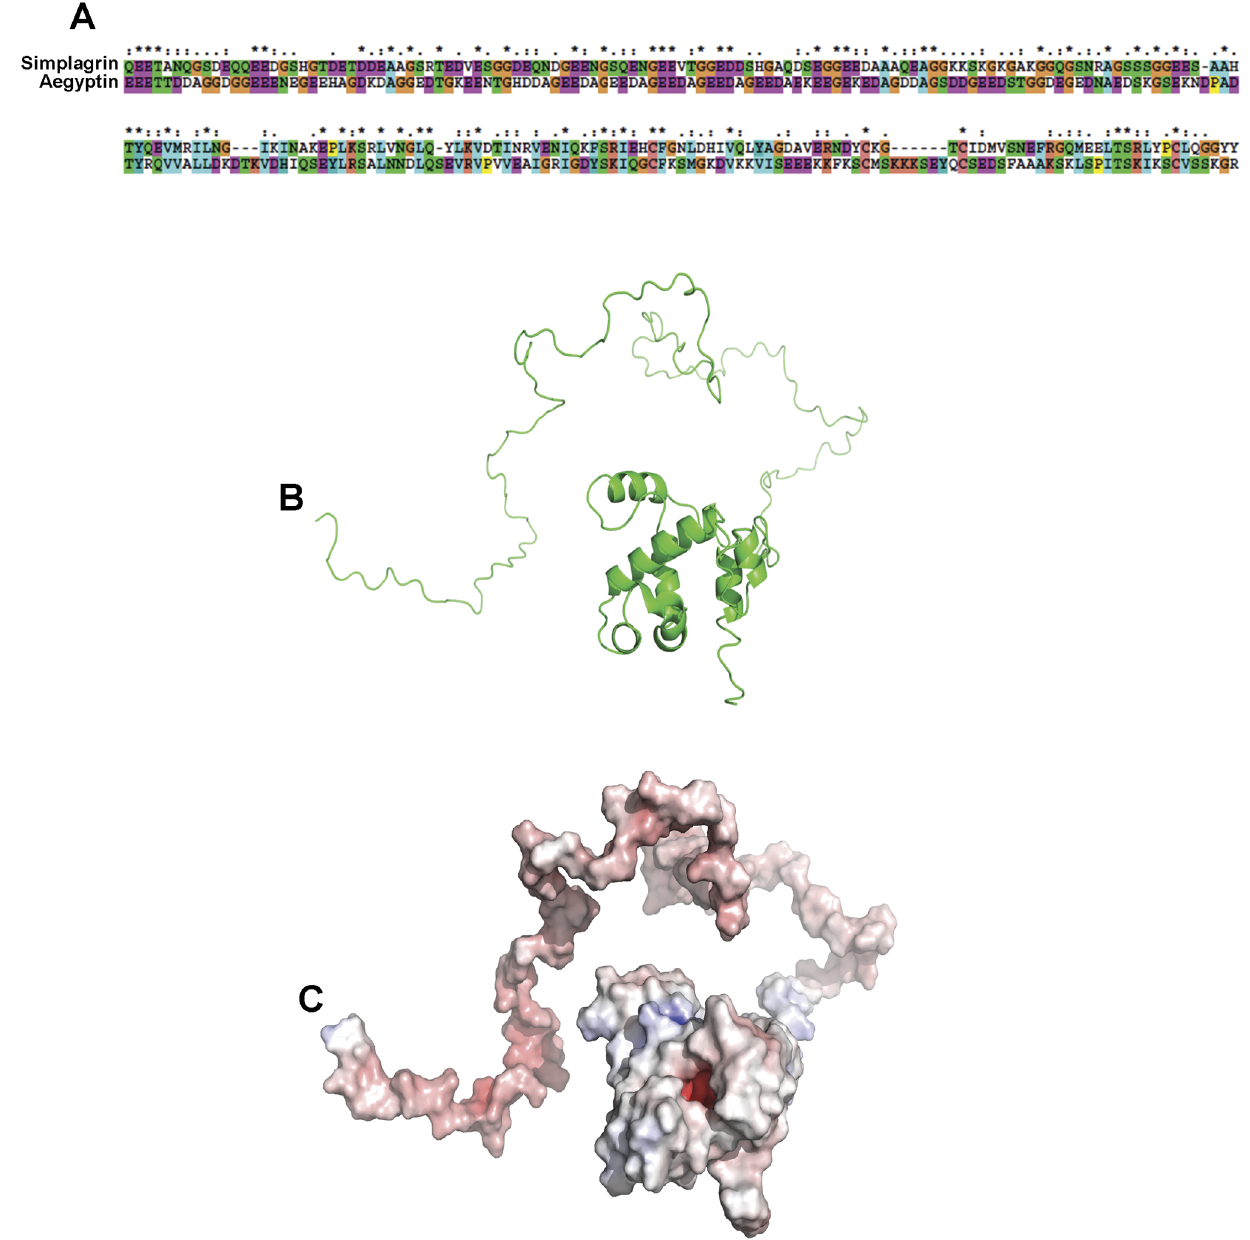
Figure 1. In silico analysis of Simplagrin. Transcriptome analysis of female salivary glands from the black fly S. nigrimanum revealed the presence of an abundant transcript distantly related to Aegyptin, a salivary collagen binding protein from Aedes aegypti. (A) Amino acid alignment of mature Simplagrin with Aegyptin reveals low overall identity (25%) between both proteins. No putative conserved domain was found. (B) Three- dimensional structure prediction of Simplagrin showing a ribbon diagram of the model generated using PyMOL. Coordinates were generated automatically by I-TASSER software. (C) Surface map of Simplagrin generated by PyMOL APBS tools. Electrostatic potential surfaces of the model showing the positively (blue) and negatively (red) charged surfaces.